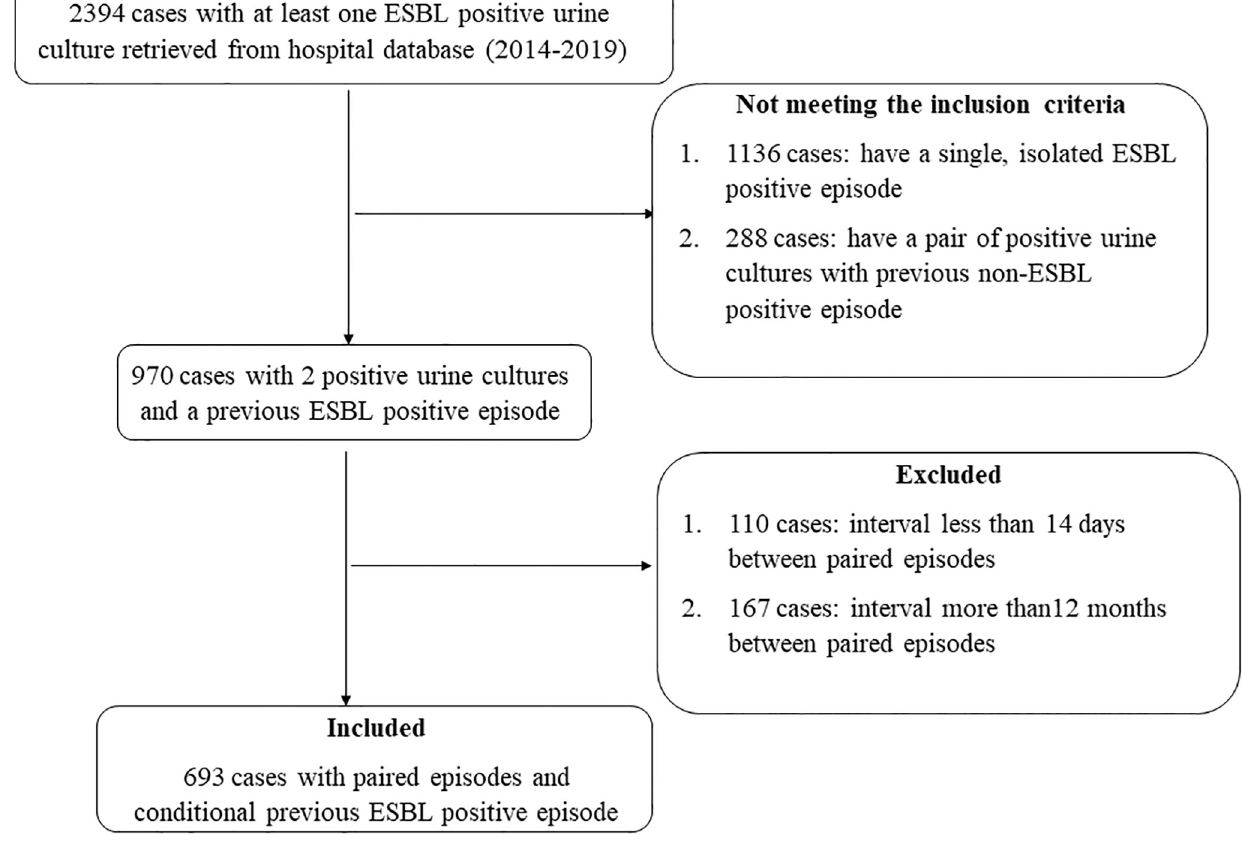
Fig 1. Summary of cases